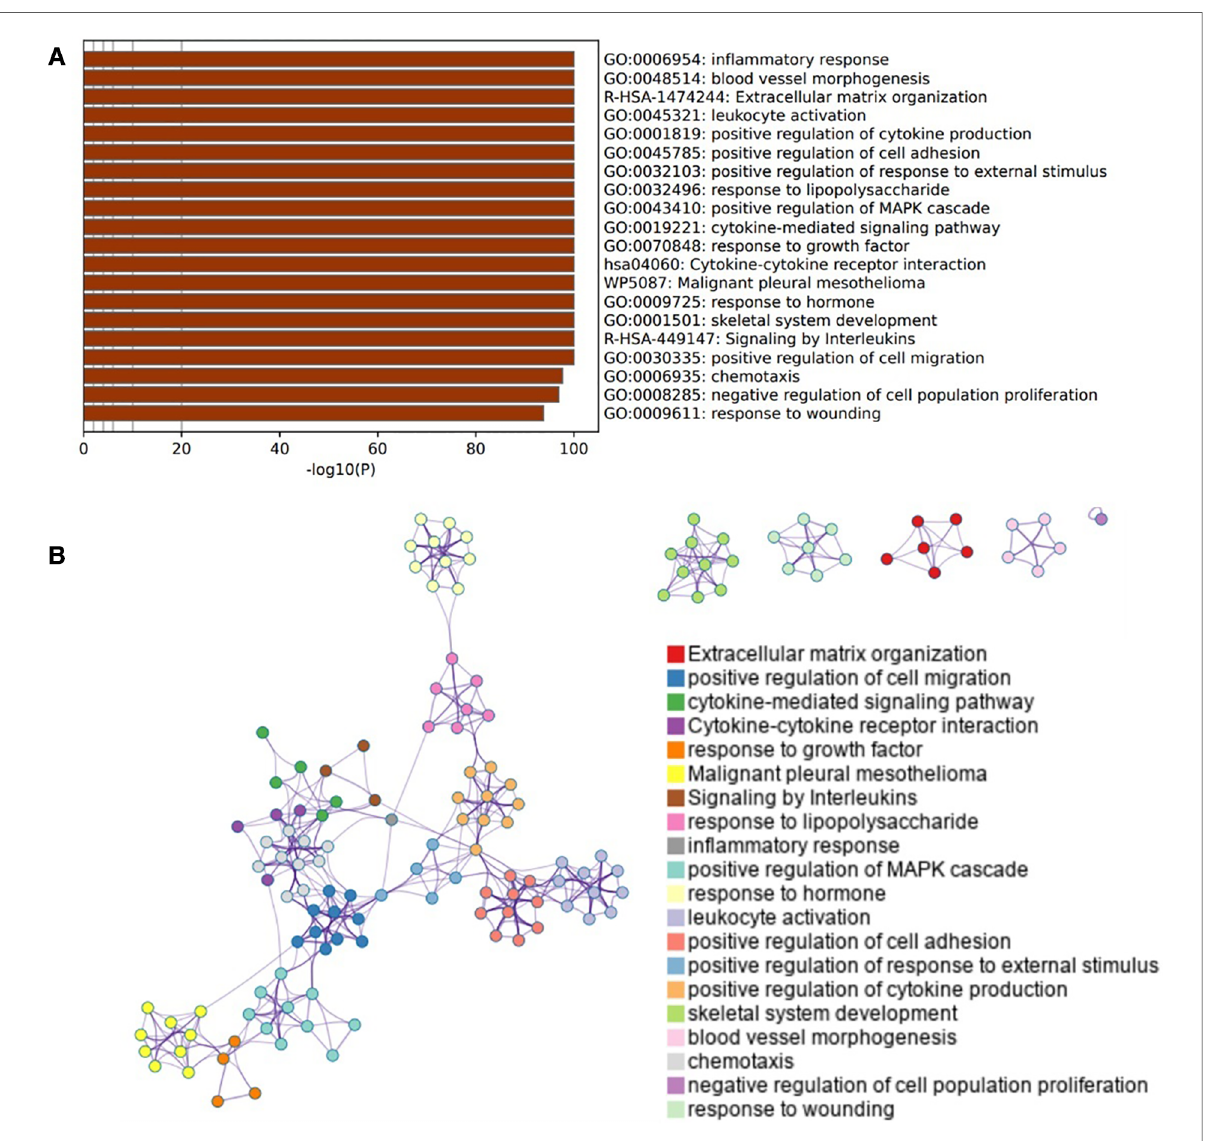
FIGURE 3 Enrichment pathway and analysis of OA-related genes. ( A ) Bar graph of 20 enriched terms were colored by p -values, and p -value<0.01 was statistically signi fi cant. ( B ) Network of enriched terms colored by cluster ID, where nodes sharing the same cluster ID are usually close to each